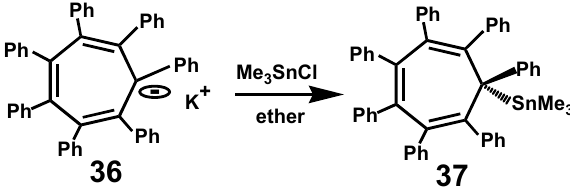
Scheme 14. Reaction of C 7 Ph 7 K with chlorotrimethylstannane.